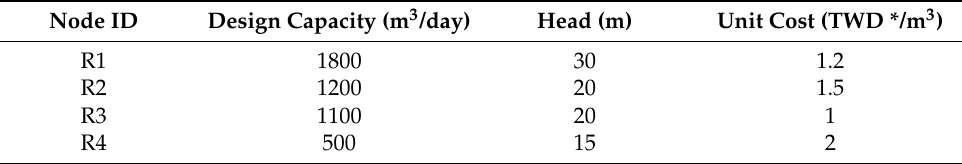
Figure 3. Case 1 configuration diagram of the WDS. Table 1. Capacity, head, and unit cost of water discharge from